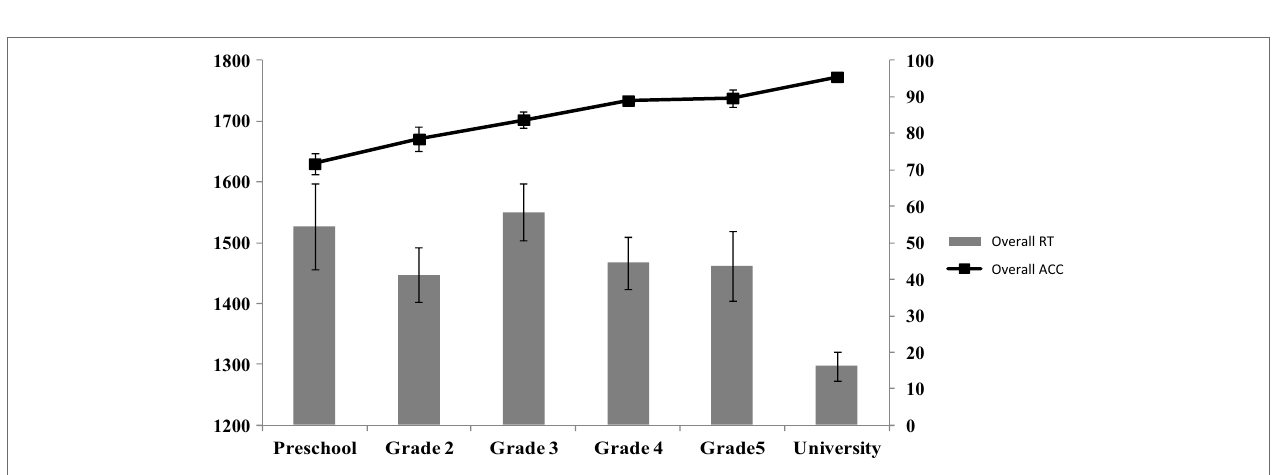
FIGURE 2 | Overall speech recognition performance obtained on all stimulus types. The left y-axis (bar plots) represents the RTs, and the right y-axis (line plots) represents the accuracy scores obtained in the different groups of participants. Error bars represent the standard errors of the